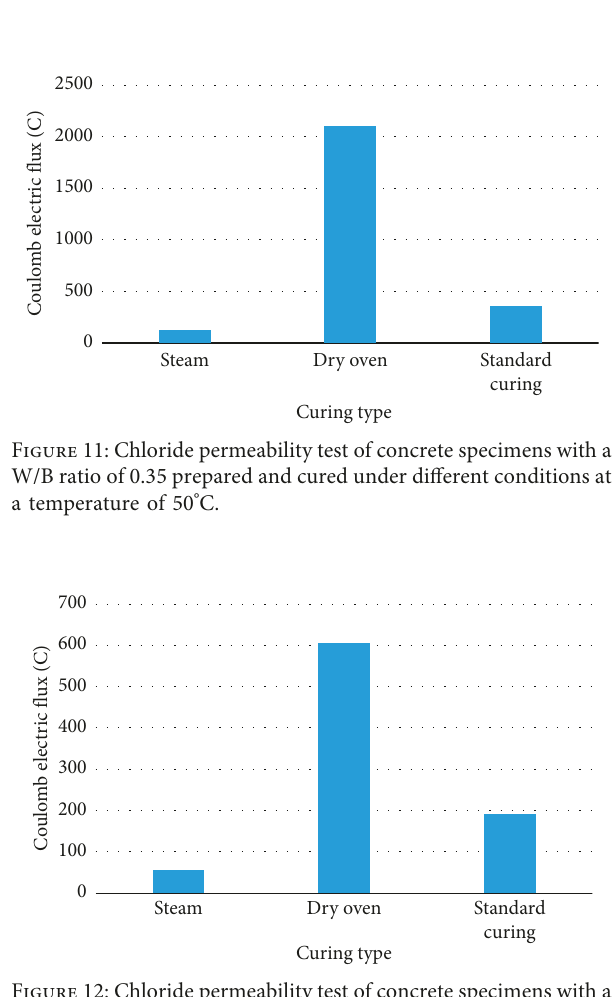
Figure 10: Chloride permeability test of concrete specimens with a W/B ratio of 0.3 prepared and cured under different conditions at a temperature of 50 ° C.